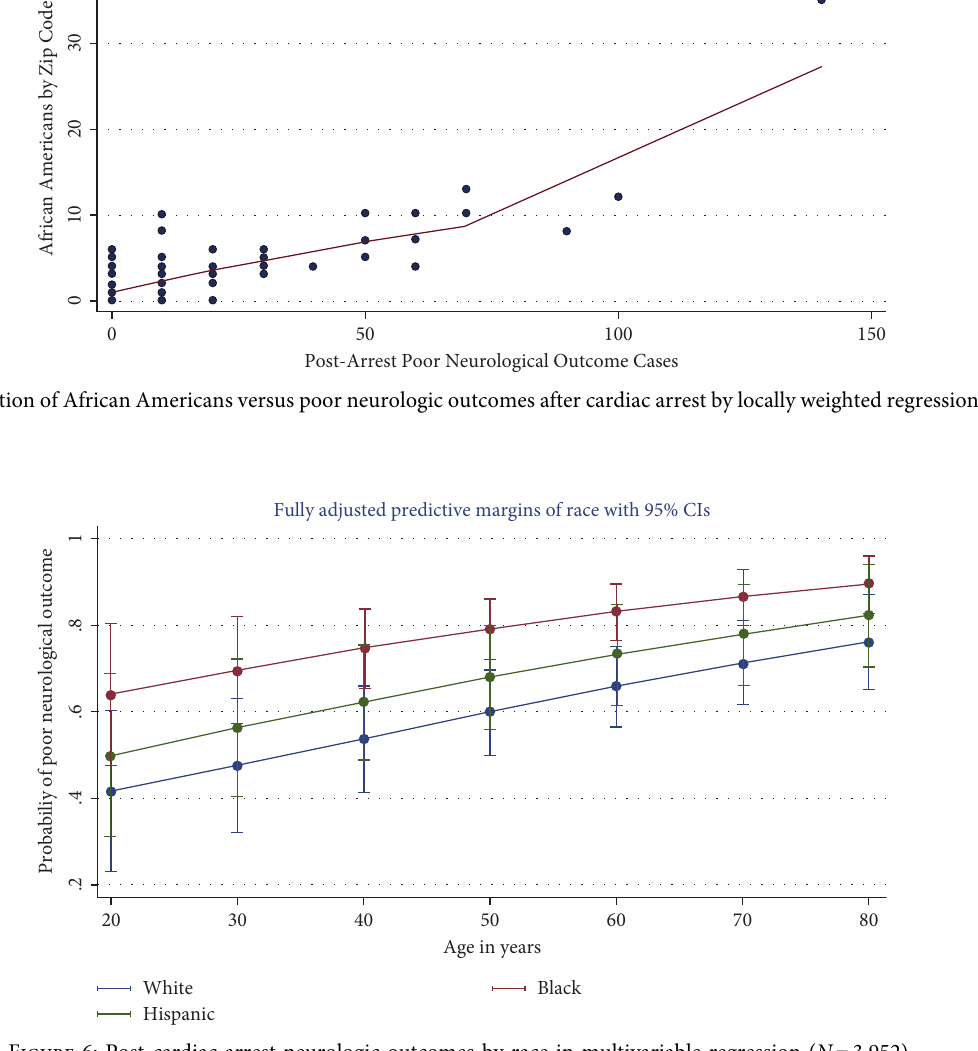
Figure 6: Post-cardiac arrest neurologic outcomes by race in multivariable regression ( N �